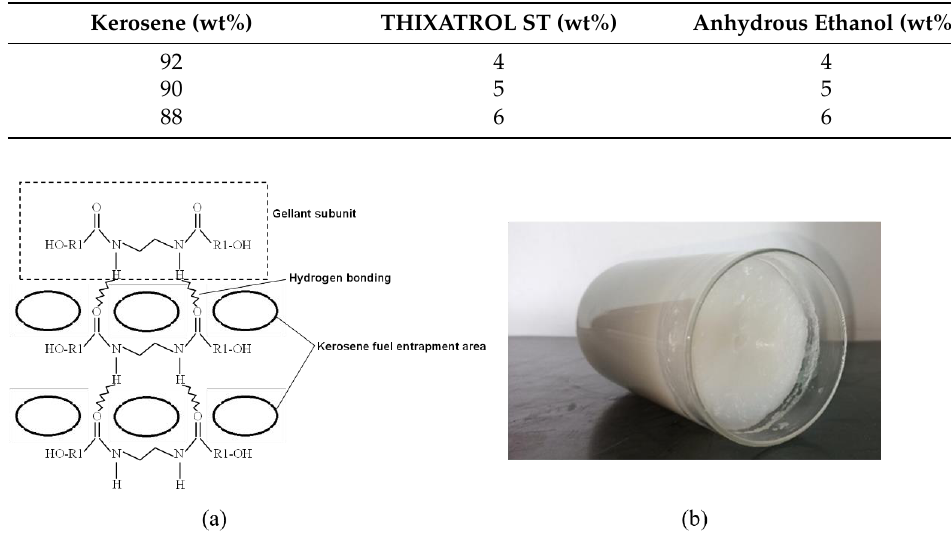
Figure 7. ( a ) Schematic of the THIXATROL ST gellant and kerosene fuel network structure (Repro- duced with permission from Ref. [35], published by Fuel Processing Technology, 2013); ( b ) sample of organic kerosene gel fuel in a static state. Table 3. The components of organic kerosene gel.